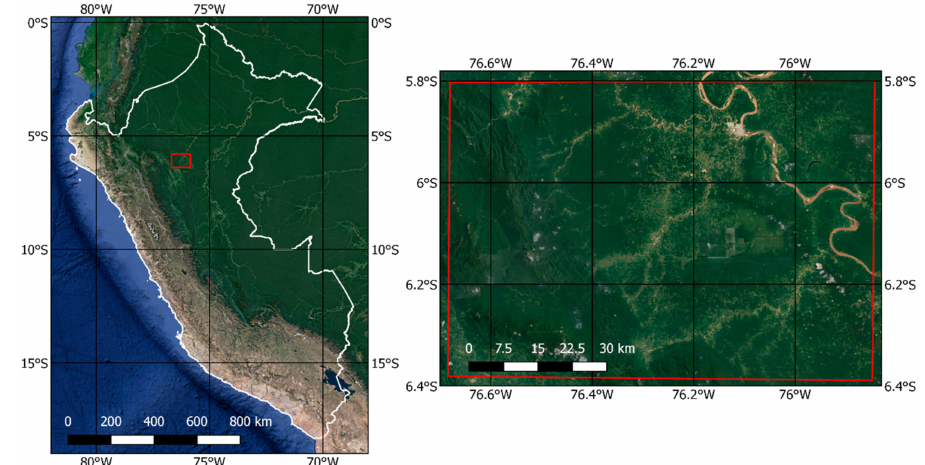
Figure 1. The study site, located in Peru (red square), on an optical background image from Google Earth (© 2018 Google). Features that can be seen in the right pane include the city of Yurimaguas along Rio Huallaga in the northeastern corner, the Cordillera Escalera mountain range in the western part, and a large oil-palm plantation in the central eastern